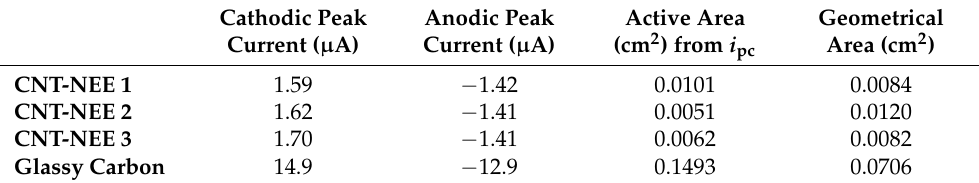
Figure 5. CNT-NEE characterization. ( a ) Optical microscope image of the electrode face at 150× magnification. The exposed area of the CNT-NEE is outlined in red. ( b ) Cyclic voltammograms of the GC electrode (black) and CNT-NEE 1 (red), CNT-NEE 2 (blue), and CNT-NEE 3 (pink) in 2.5 mM Ruhex and 25 mM KCl at a scan rate of 0.01 V/s normalized by the active area of each electrode. Table 1. Characteristics of CNT-NEEs and the glassy carbon electrode.